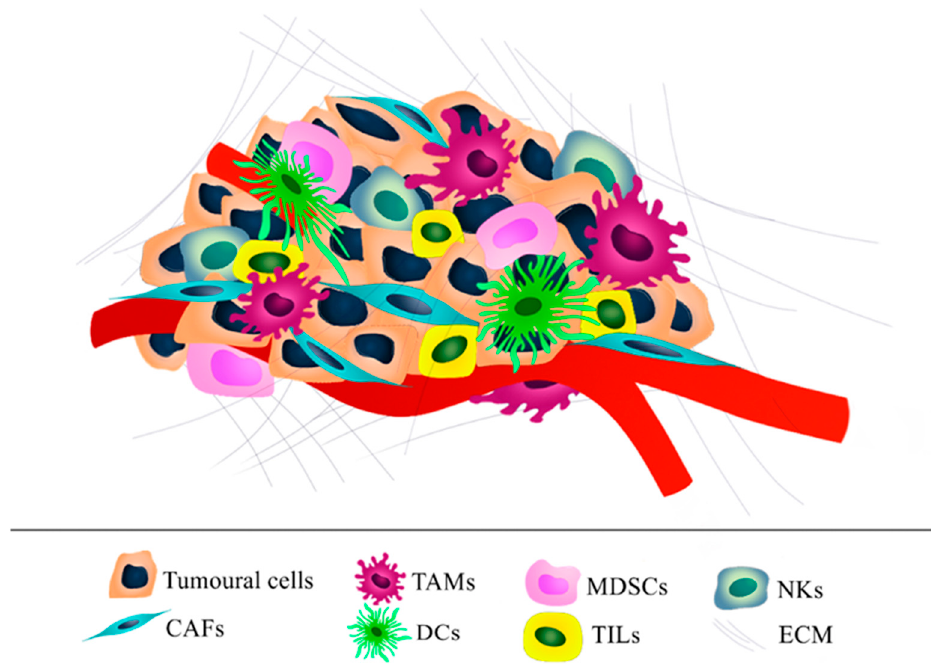
Figure 2. Graphical representation of ovarian tumor microenvironment (TME). In particular, the following components are represented: tumoral cells, cancer-associated fibroblasts (CAFs), tumor- associated macrophages (TAMs), dendritic cells (DCs), myeloid-derived suppressor cells (MDSCs), tumor-infiltrating lymphocytes (TILs), natural killers (NKs) and ECM structural elements.